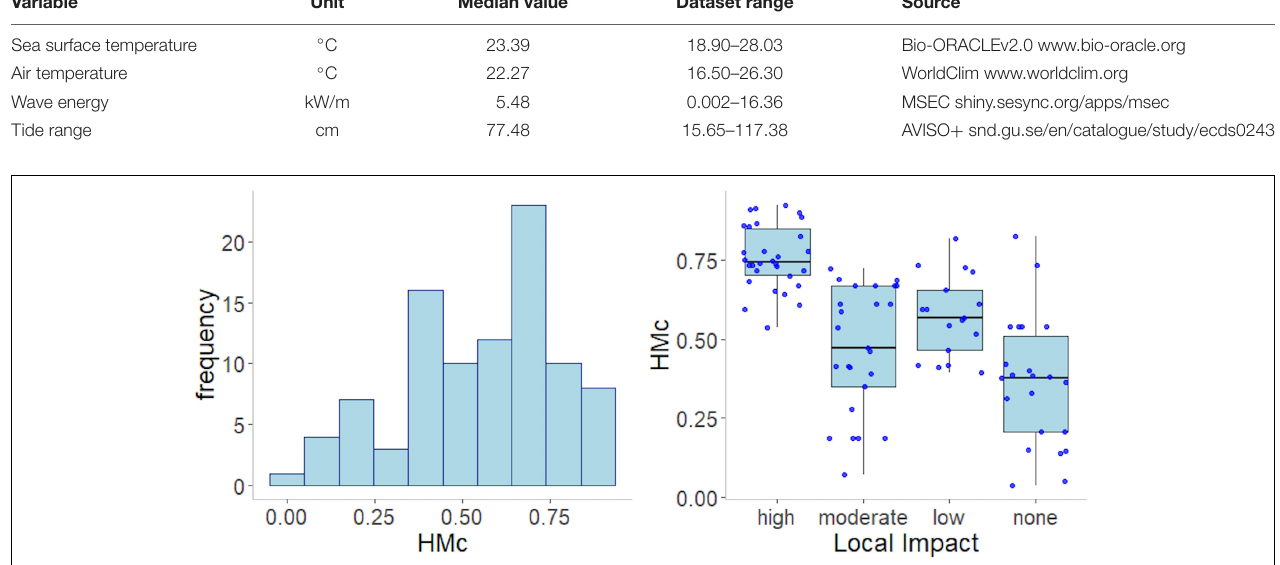
FIGURE 2 | Histogram of values of the cumulative Human Modification (HMc) and relationship with the local human modification levels of 94 sandy beach sectors from Western Atlantic coast.